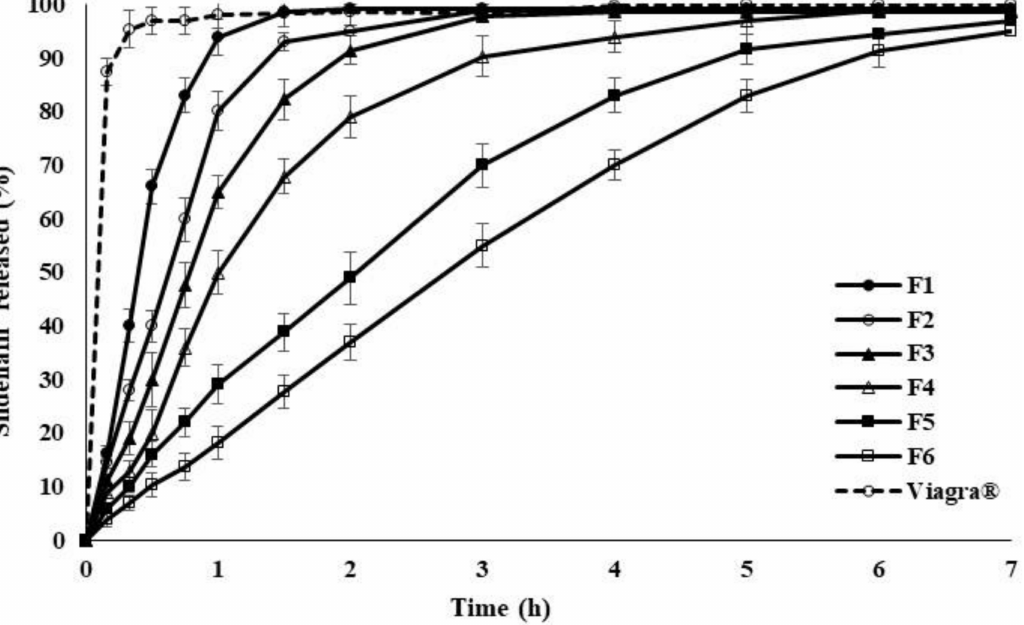
Figure 2. The percentage of SDF release from polymer matrices of various ratios of P-188 and HPMC over 7 h, using distilled water at 37 ◦ C, values are means ± S.D. ( n =